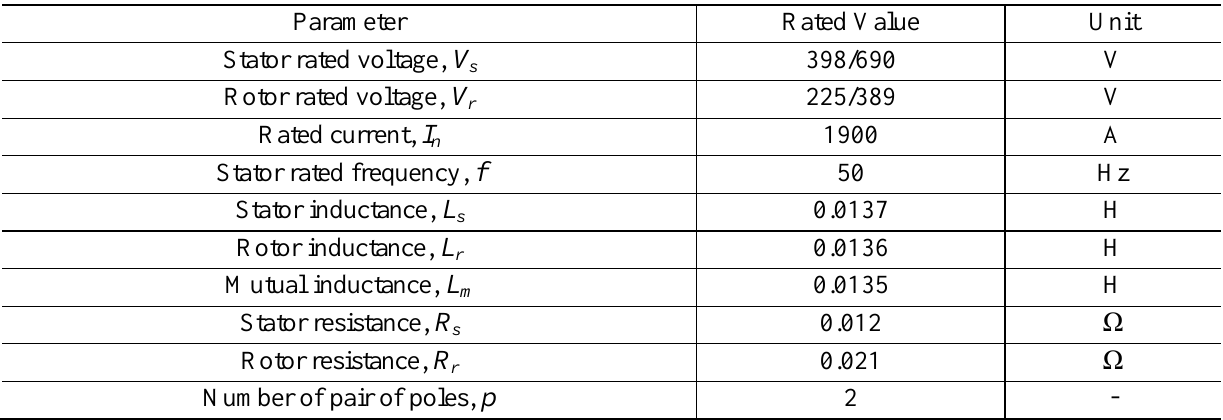
Table 2. Doubly fed induction generator